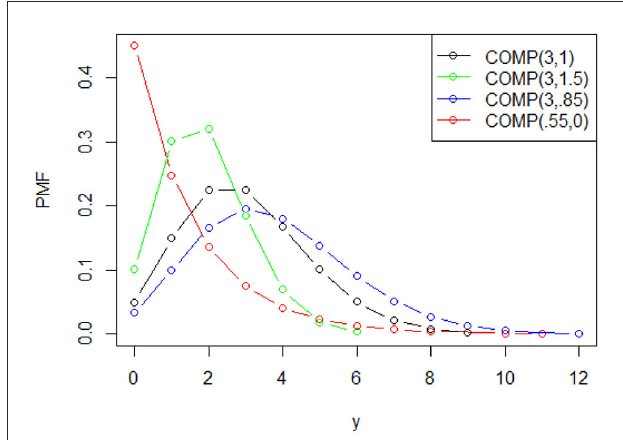
FIGURE1 Probability mass function (PMF) for the simulated data from the COMP